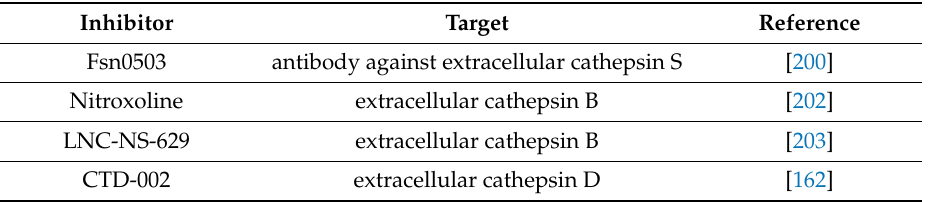
Table 4. List of available extracellular cathepsin